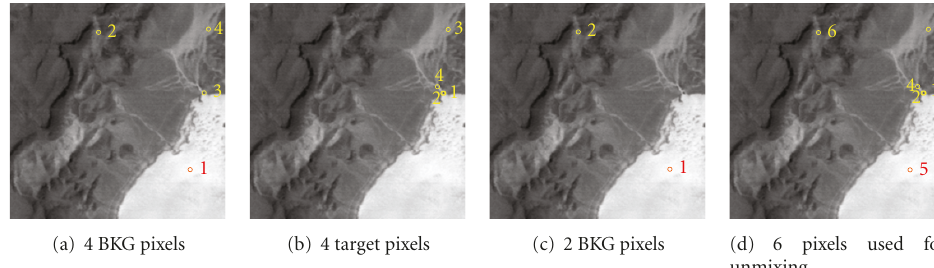
Figure 31: UNCLS-generated BKG and target pixels (a) 4 BKG pixels in original data; (b) 4 target pixels in sphered data; (c) 2 pixels identified as BKG pixels; (d) a total of 6 pixels obtained by combining the pixels in